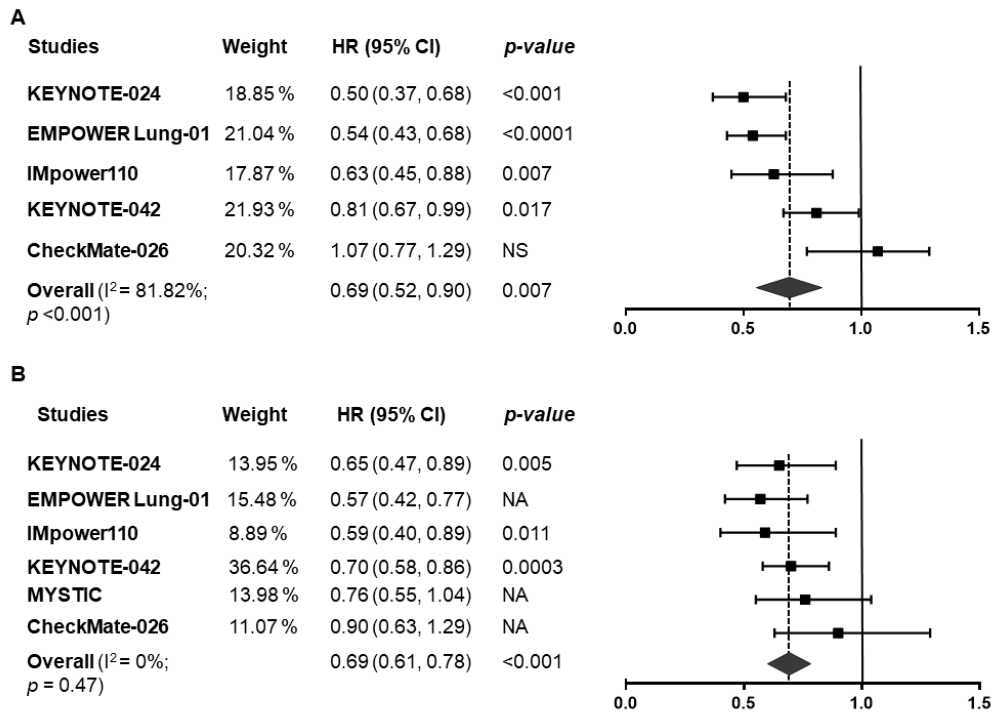
Figure 2. Forest plot of pooled hazard ratios for ( A ) progression-free survival (PFS) and ( B ) overall survival (OS) in patients who received PD-1/PD-L1 inhibitors vs. chemotherapy alone. HR, hazard ratio; CI, confidence interval.